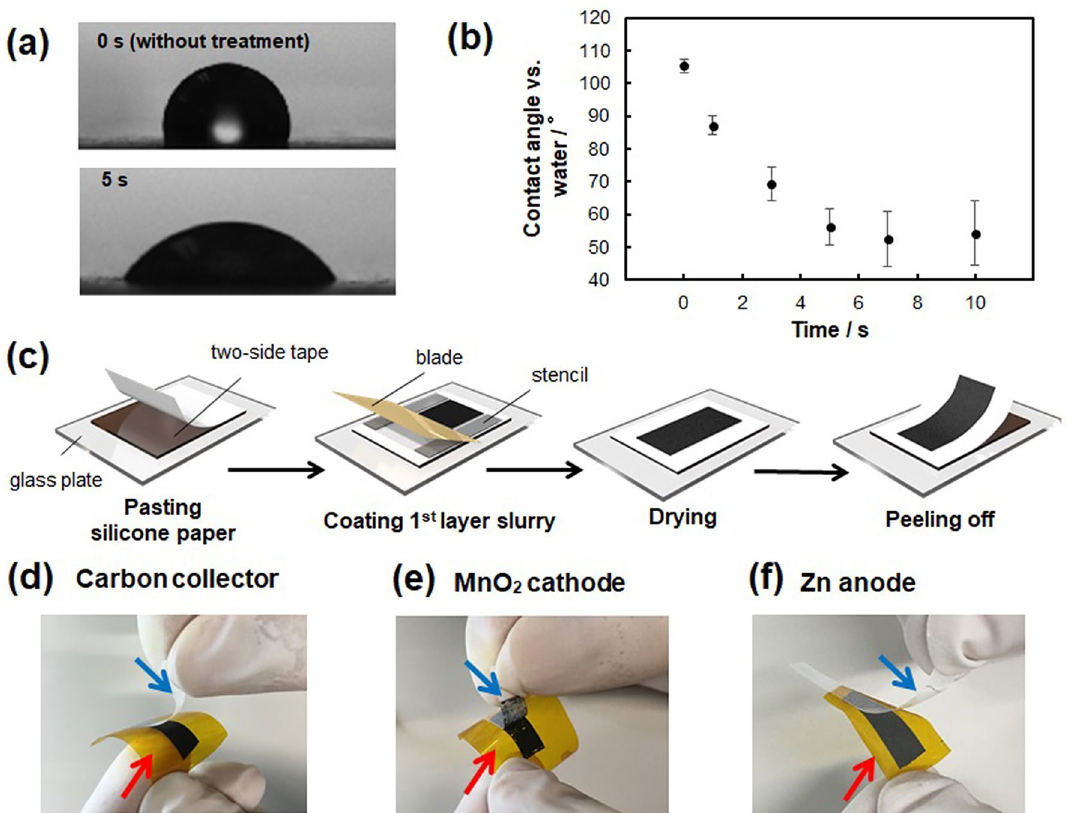
Figure 3. Oxygen plasma treatment of the silicone-based supporting paper surface with oxygen plasma and preparation of first layer composites. ( a ) Water droplets on the pristine and oxygen plasma-treated (100 W for 5 s) silicone-based paper. ( b ) Contact angles of water droplets on the supporting paper treated for different irradiation time. ( c ) Steps for the preparation of the first layer composite on the oxygen-plasma-treated paper. ( d – f ) Photographs of the peeled Kapton tape (red arrow) with the electrode composite from the plasma- treated silicone-based paper (blue arrow). The illustration of ( c ) designed with the free software POV-Ray for windows—version